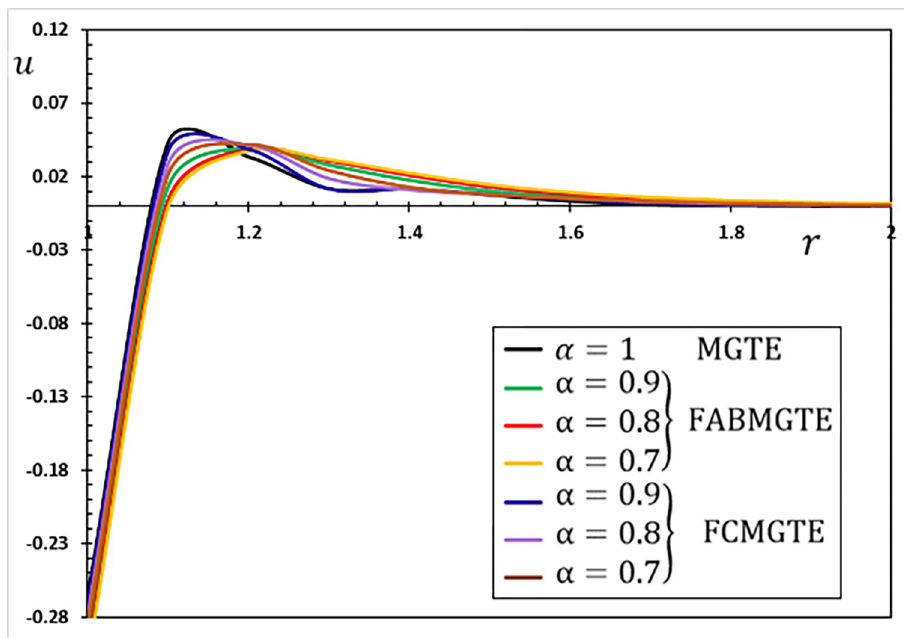
Fig 10. The displacement variation u for different fractional operator